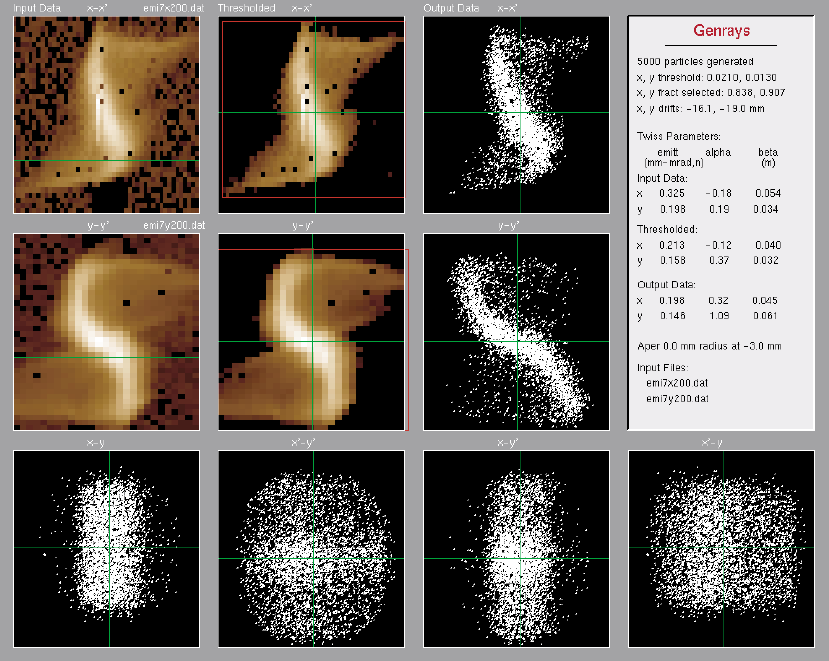
FIG. 1. (Color) Phase-space projections of the measured and simulated LEBT beam. Leftmost colored plots are raw data of LEBT emittance measurements. The colored plots in the second column are filtered data. And rightmost plots are generated beam distri- bution based on the filtered data.